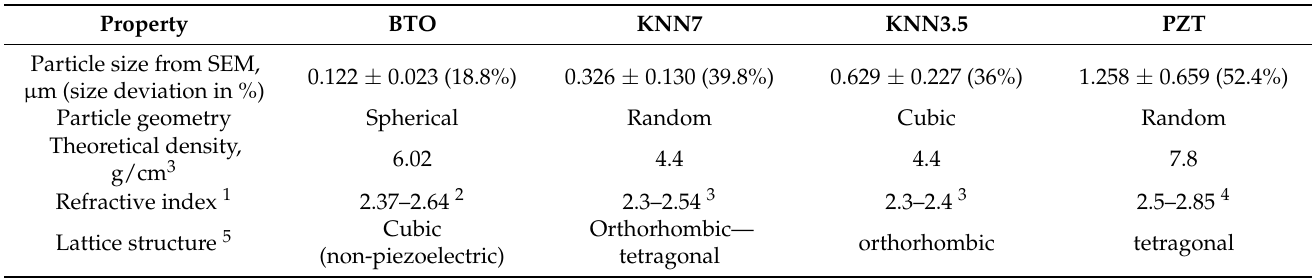
Table 1. Properties of piezoelectric ceramic